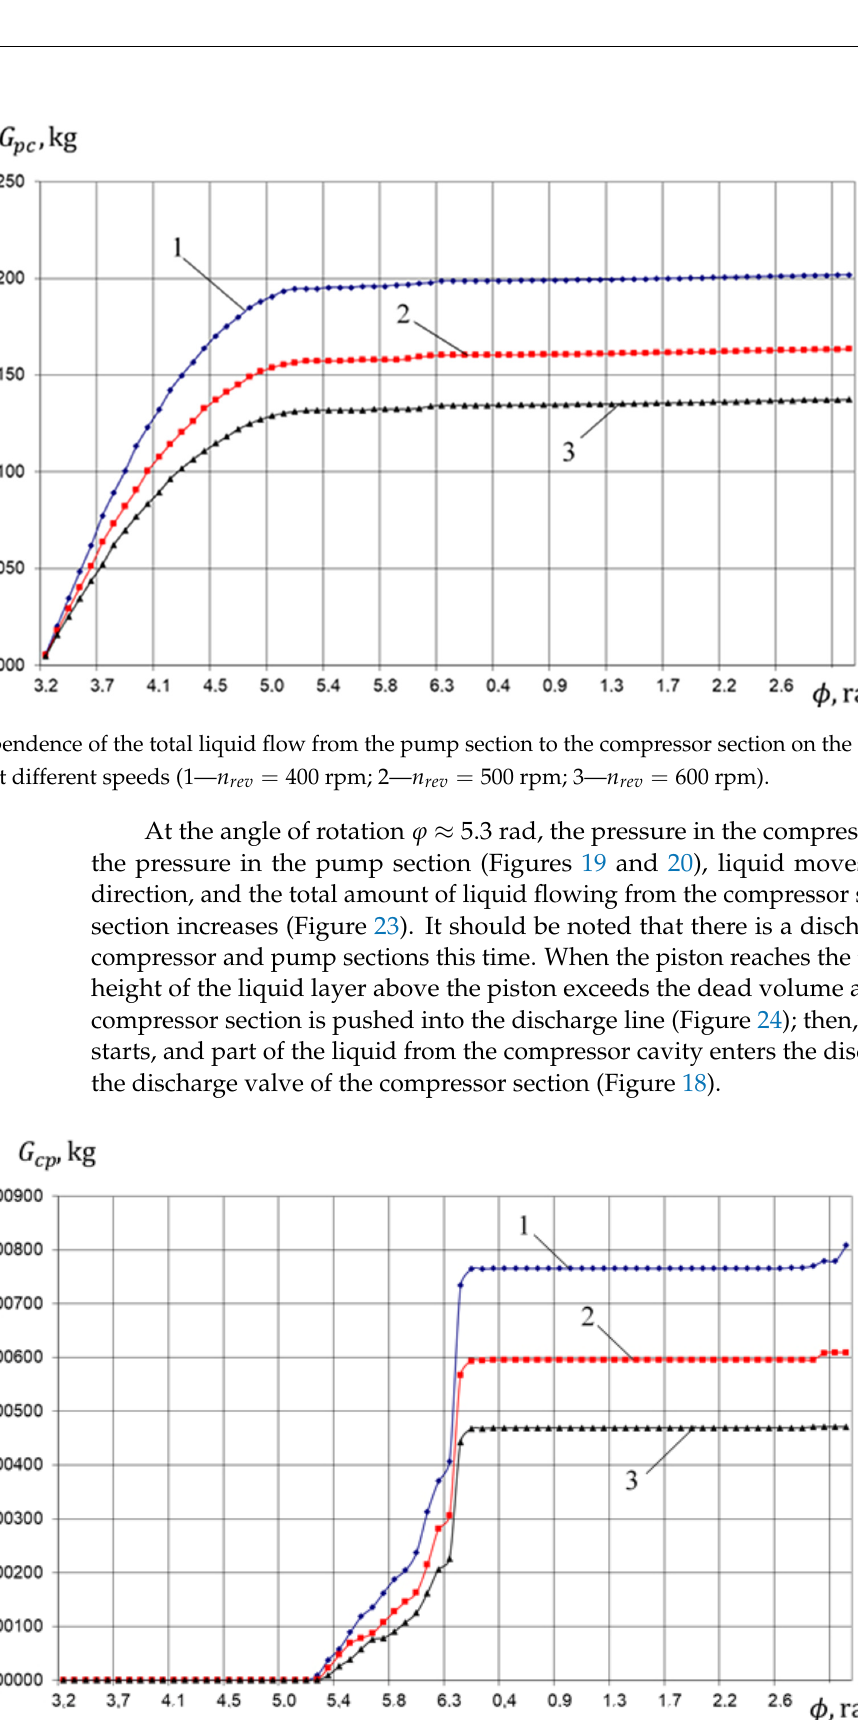
Figure 21. Dependence of the length of the gap seal on the angle of rotation of the crankshaft.